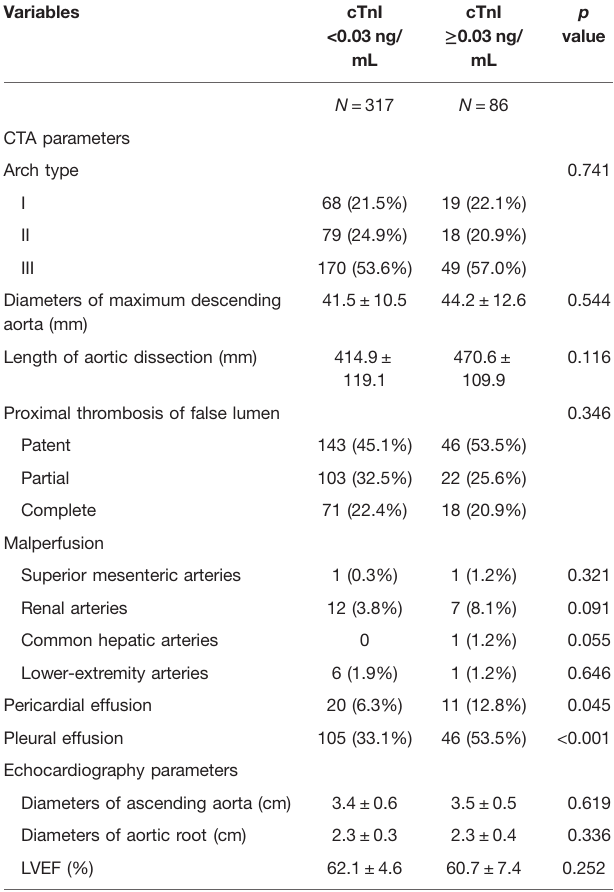
TABLE 2 | Characteristics of CTA and echocardiography strati fi ed with cTnI <0.03 ng/mL and ≥ 0.03 ng/mL